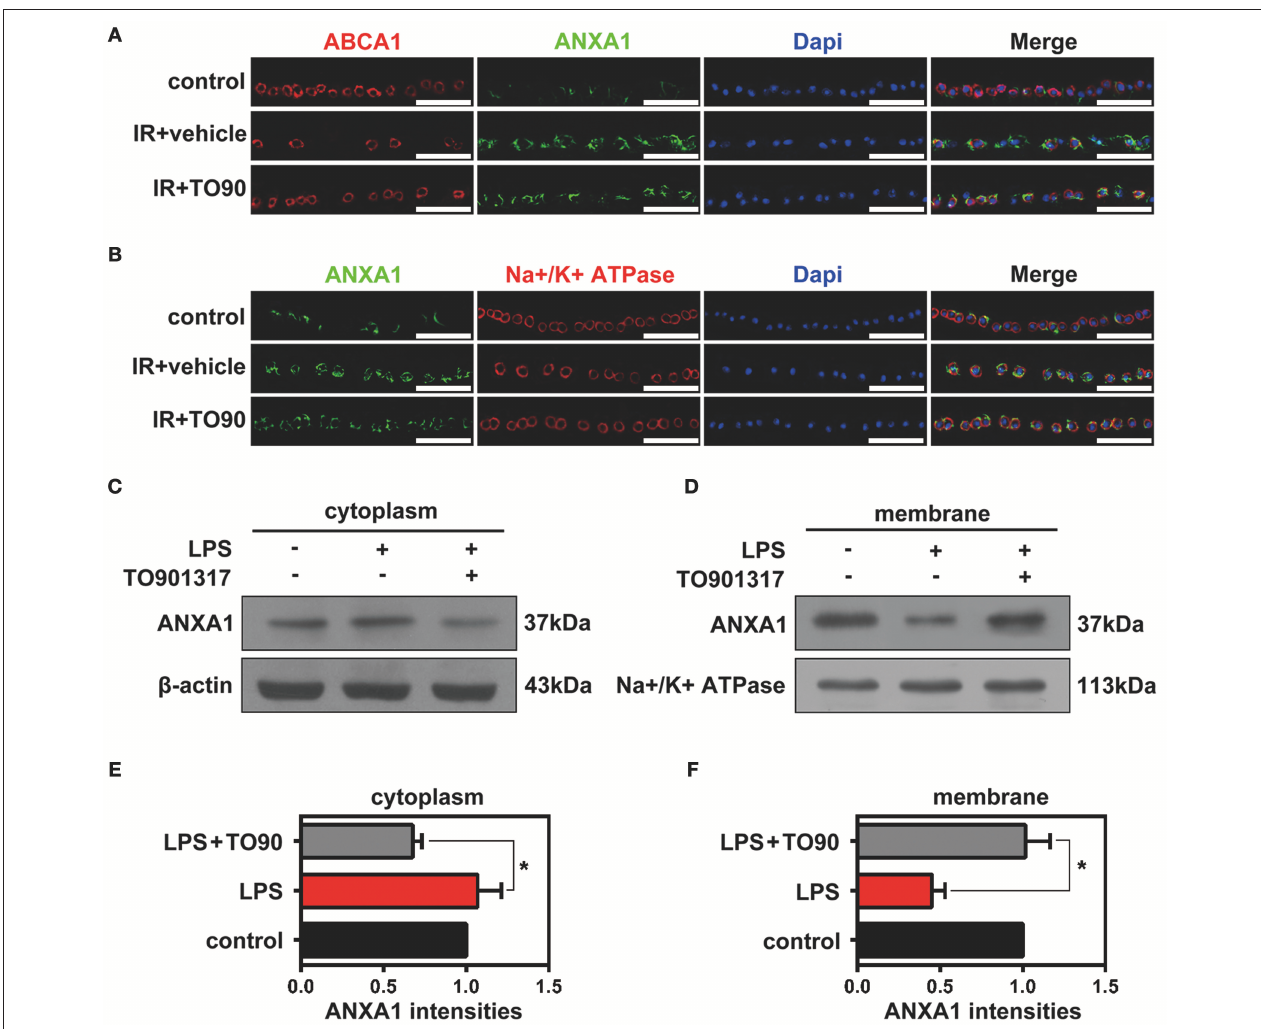
FIGURE 3 | The effects of TO901317 on the ANXA1 translocation to the cell membrane. (A) Immunofluorescence results indicate that ABCA1 and ANXA1 can be co-localized on the membrane of cells in the GCL ( n = 6 retinas per group). Blue: DAPI; red: ABCA1; green: ANXA1. Scale bar = 50 µ m. (B) TO901317 promotes translocation of ANXA1 to the cell membrane after IR in vivo ( n = 6 retinas per group). Blue: DAPI; red: Na + /K + -ATPase; green: ANXA1. Scale bar = 50 µ m. (C,D) Western blots demonstrate that TO901317 (3 µ M) increases the protein levels of ANXA1 in the membrane of LPS-stimulated HEK293 cells, while ANXA1 expression in the cytoplasm is reduced. (E,F) Statistical analysis of the data shown in (C,D) . The data from three independent experiments are expressed as the means ± S.D. * P < 0.05, one-way ANOVA with Bonferroni post hoc